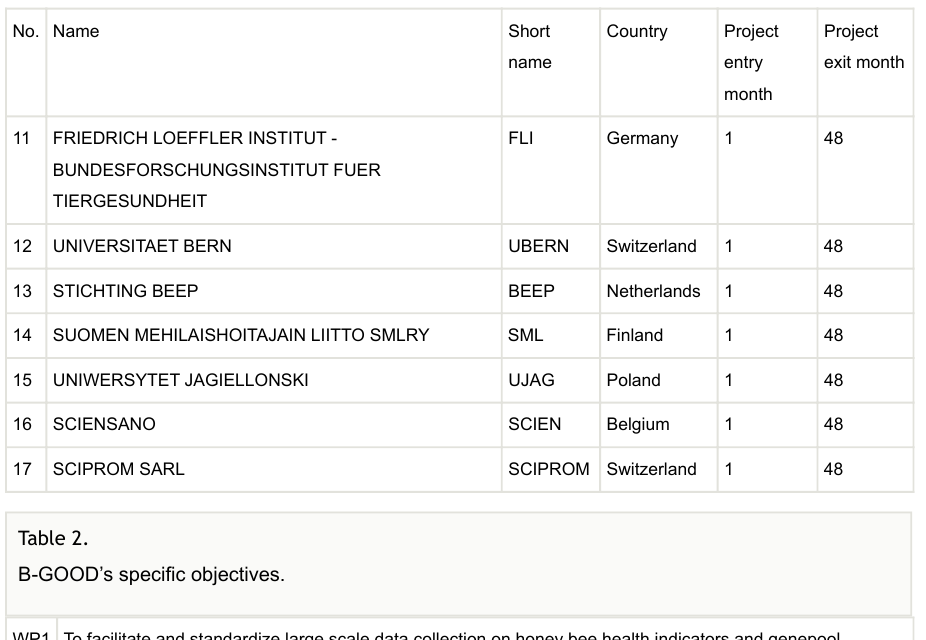
B-GOOD’s specific